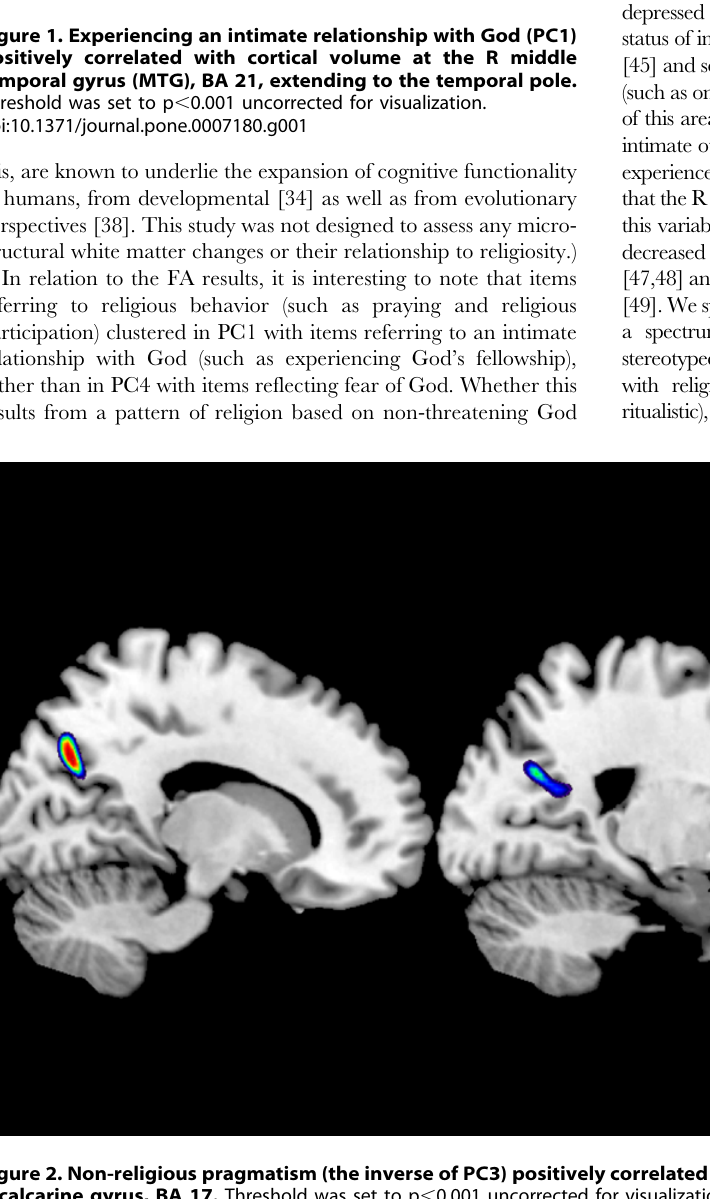
Figure 2. Non-religious pragmatism (the inverse of PC3) positively correlated with cortical volume at the R precuneus, BA 7 and the R calcarine gyrus, BA 17. Threshold was set to p , 0.001 uncorrected for